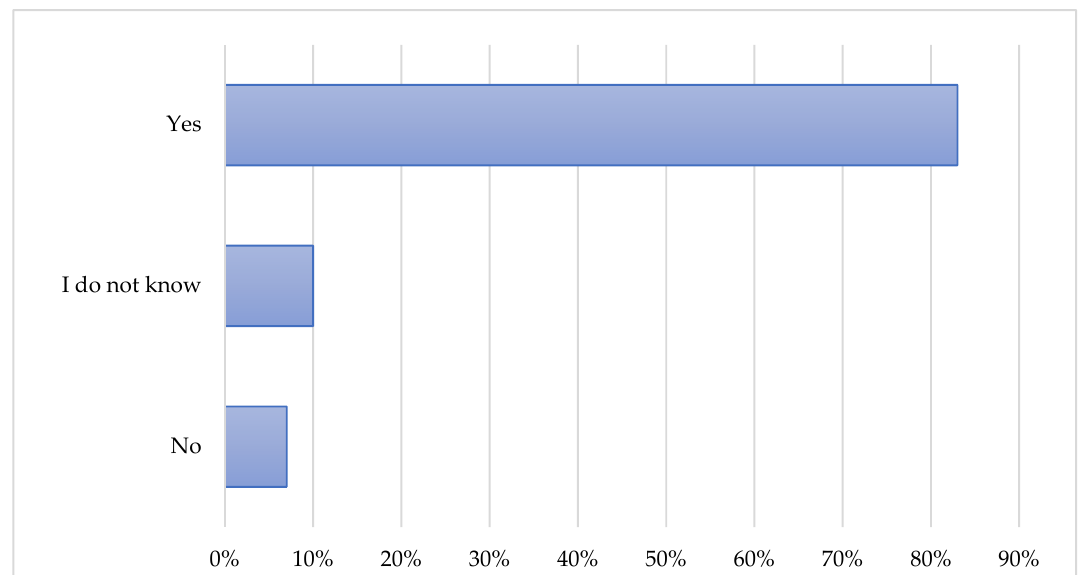
Figure 4. Percentage of farmers according to the communication medium observed. 3.3. Main Brakes, Accelerators and Perceptions in the Adoption of Agroecological Practices In Figure 5 it can be seen that the most important brakes/barriers for farmers when it comes to adopting agroecological practices are: “Loss of producer income”, “Lack of social awareness regarding the production of ecological products”, “Low prices at origin and/or market”, and “lack of agroecological training, technical and research advice”. On the other hand, we have the less important barriers such as “low diversity organic products”, “the economic situation does not allow to put agroecology into practice”, and the “type of soil and relief of the farm”. Thus, farmers tend to give more importance to those barriers that are more focused on the economic field (related to aid and payment for product), social